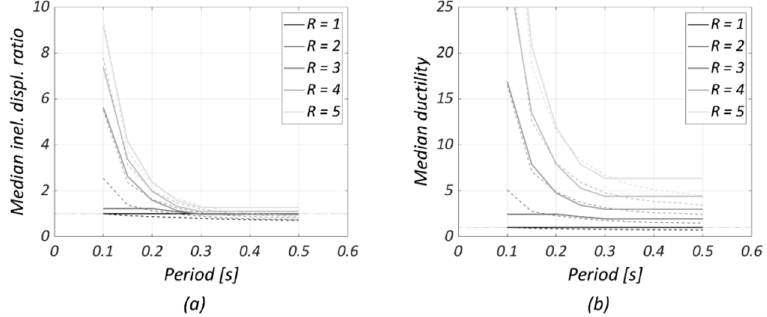
Figure 6. Comparison between the predictions by the CSM of FEMA 440 (solid lines) and the results from NLTHA of Suite 2-A (dashed lines): ( a ) median 𝐶 (cid:3019) – 𝑅 – 𝑇 curves, and ( b ) median 𝜇 (cid:3019) – 𝑅 – 𝑇 curves.